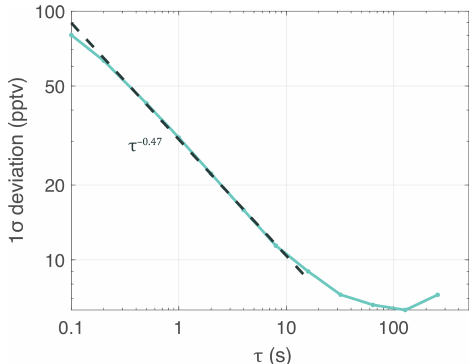
Figure 5. Allan deviation plot for 1.5h of sampling zero air at con- stant pressure (944mbar). The 1 σ precision is expressed in pptv equivalents of O 3 as a function of the integration time τ . The curve demonstrates a precision of 31pptv in a 1s integration time. The dashed line shows a τ − 0 . 47 decay for short integration times ( < 10s), comparable to the τ − 1 / 2 decay expected for white